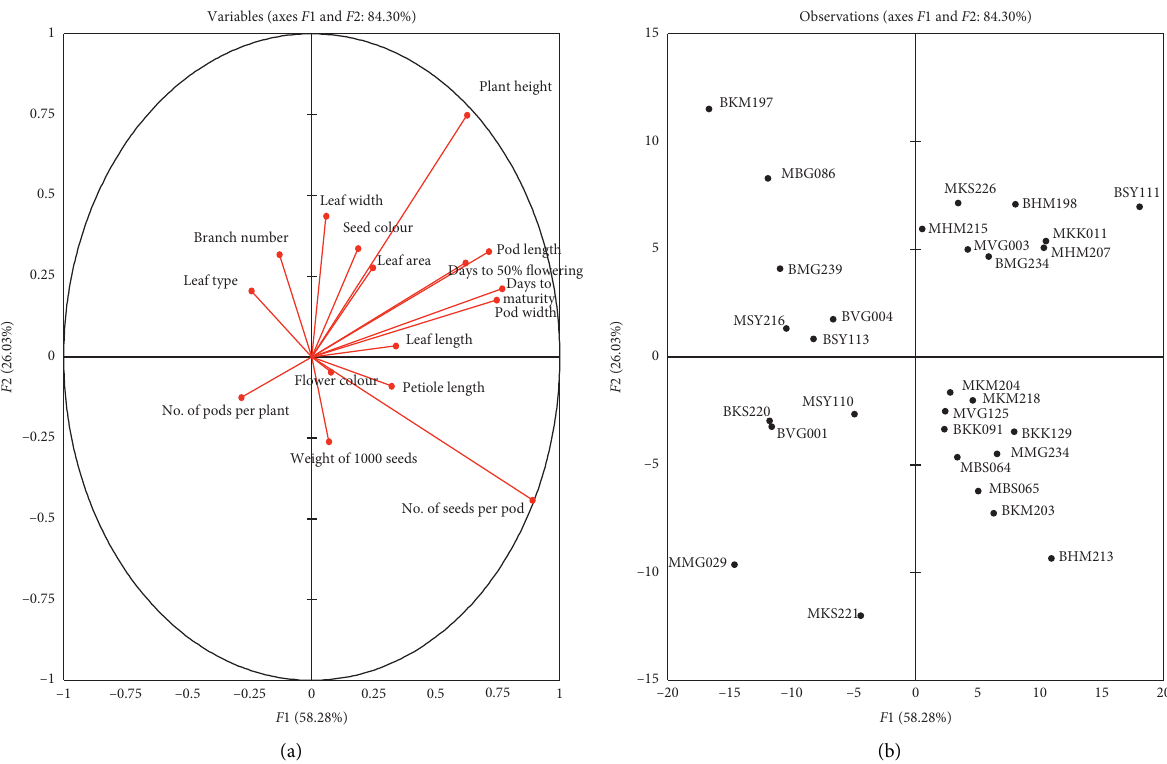
Figure 3: Pictorial illustration of correlations between variables and factors (a) and biplot between accessions and factors